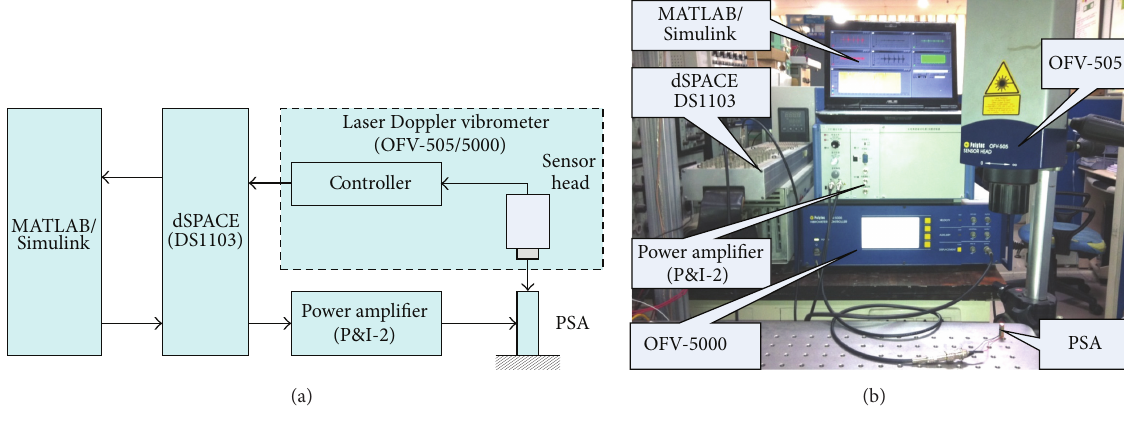
Figure 4: Experimental setup for PSAs: (a) the schematic and (b) the